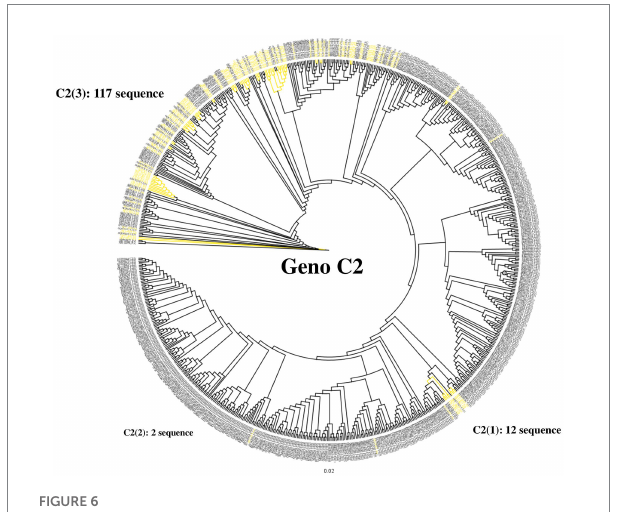
FIGURE 6 Differentiation at the clade level of 131 Korean chronic patients via phylogenetic analysis of the HBV reverse transcriptase region. Phylogenetic tree of reverse transcriptase from HBV subgenotype C2. Distribution of 131 Korean patients by alignment with 683 previously constructed subgenotype C2 reverse transcriptase sequences. Most Korean patients (89.3%) are infected with subgenotype C2(3). Korean patient sequences are shown in yellow